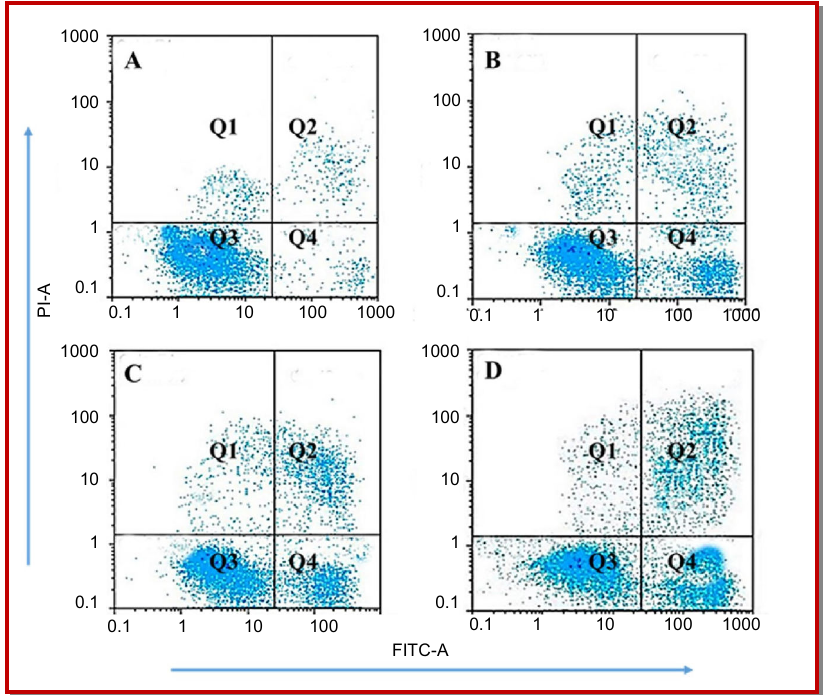
Figure 5: Quantification of theaflavin-3-gallate-induced apoptosis in human lung cancer cells (A-549). The cells were subjected to different doses of theaflavin-3-gallate (0, 20, 80 and 160 µM) for 48 hours and analyzed by flow cytometry with annexin V-FITC/ PI staining. The different quadrants Q1, Q2, Q3 and Q4 represent necrotic cells, late apoptotic cells, viable cells and early apoptotic cell population respectively. Percentage of apoptotic cells increases from 5.2% in control cells (A), to 17.1%, 49.1% and 78.1 % in 20 µM (B), 80 µM (C) and 160 µM (D) theaflavin-3-gallate-treated cells